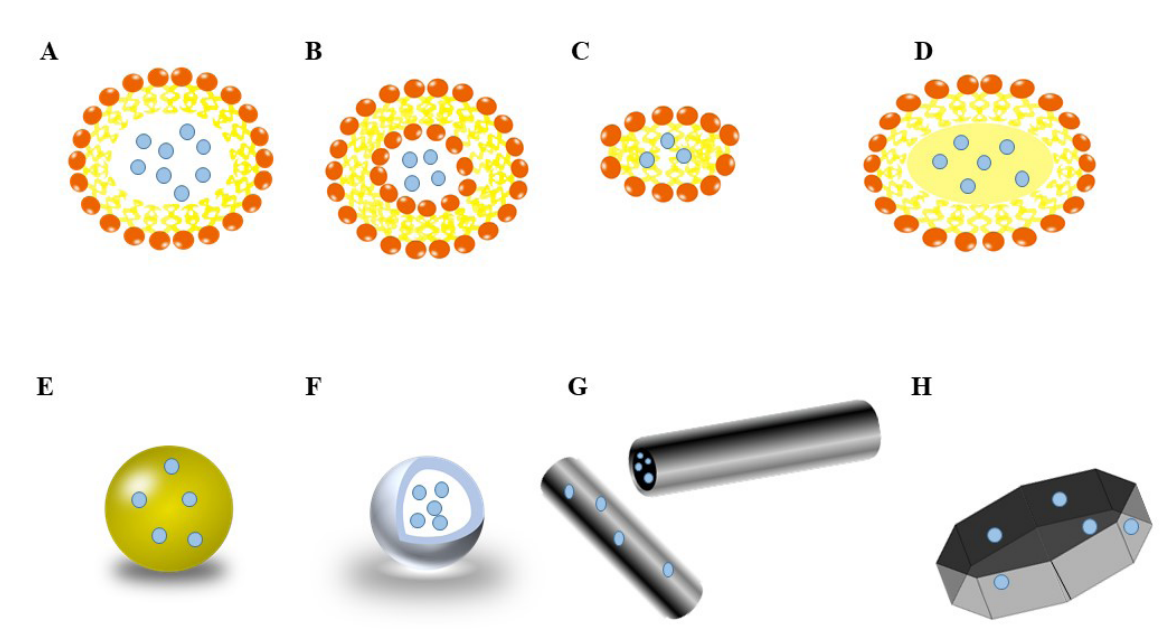
Figure 2 Graphical representations of the structure of various nanoparticulate systems. ( A-D ). Lipid Based Systems ( A ). Micelles ( B ). Liposomes ( C ). Lipid Nanodiscs ( D ). Solid Lipid Nanoparticles (SLN). ( E-H ). Polymeric and Metallic / Inorganic Systems ( E ). Nanospheres ( F ). Nanocapsules / Polymeric Micelles ( G ). Nanofibers and Nanotubes ( H ).